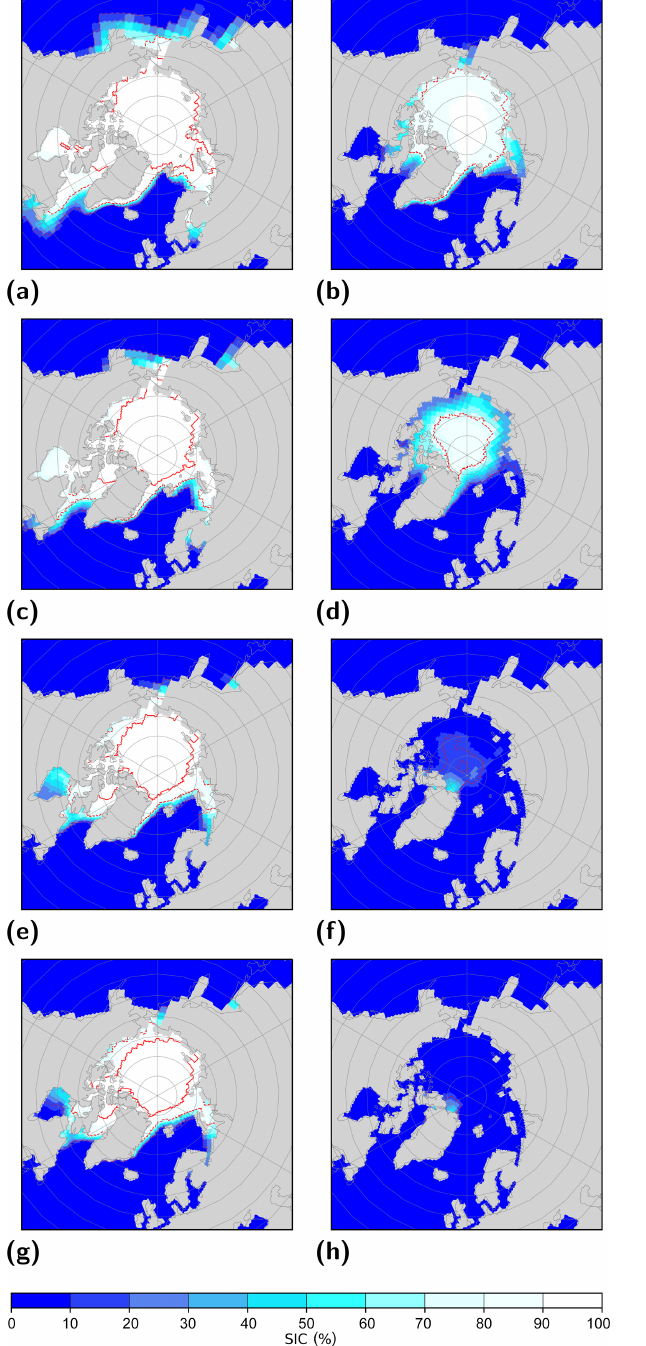
Figure 14. Sea ice coverage (SIC) in the Northern Hemisphere for boreal spring (MAM, a, c, e, g ) and boreal autumn (SON, b, d, f, h ) depending on the volume mixing ratio of carbon dioxide for mod- ern geography. Shown are (a, b) E280, (c, d) E400, (e, f) E560, and (g, h) E600. Grey shading illustrates the land–sea mask. Red con- tours illustrate SIC isolines of 15% (dotted), 75% (dashed), and 95% (solid).